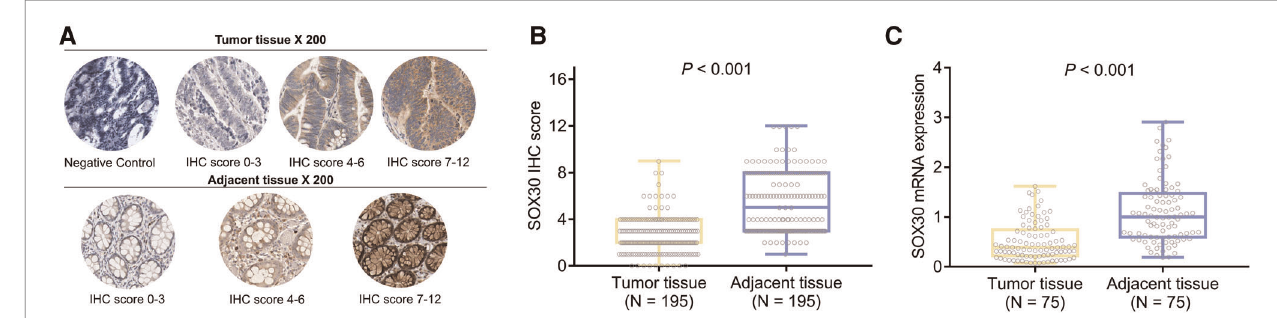
FIGURE 1 | SOX30 in CRC patients. IHC images of SOX30 expression in tumor tissue and adjacent tissue ( A ); comparison of SOX30 IHC score ( B ) and SOX30 mRNA expression ( C ) between tumor tissue and adjacent tissue. SOX30, sex-determining region Y-box containing gene 30; IHC, immunohistochemistry; CRC,